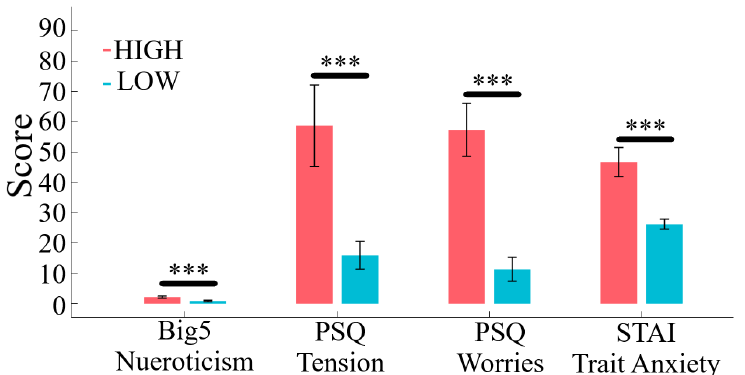
Figure A11. Paired Wilcoxon rank sum test. For every questionnaire, HIGH stress-susceptible participants’ responses were associated significantly larger values (with large effect sizes) than the LOW stress-susceptible participants. In this figure, the asterisks mark these significant differences (*** p <